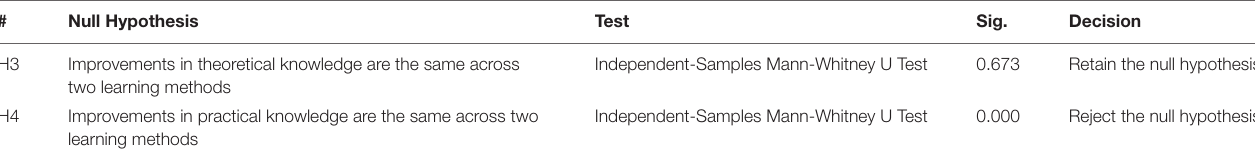
TABLE 9 | Non-parametric test for improvement difference evaluation.